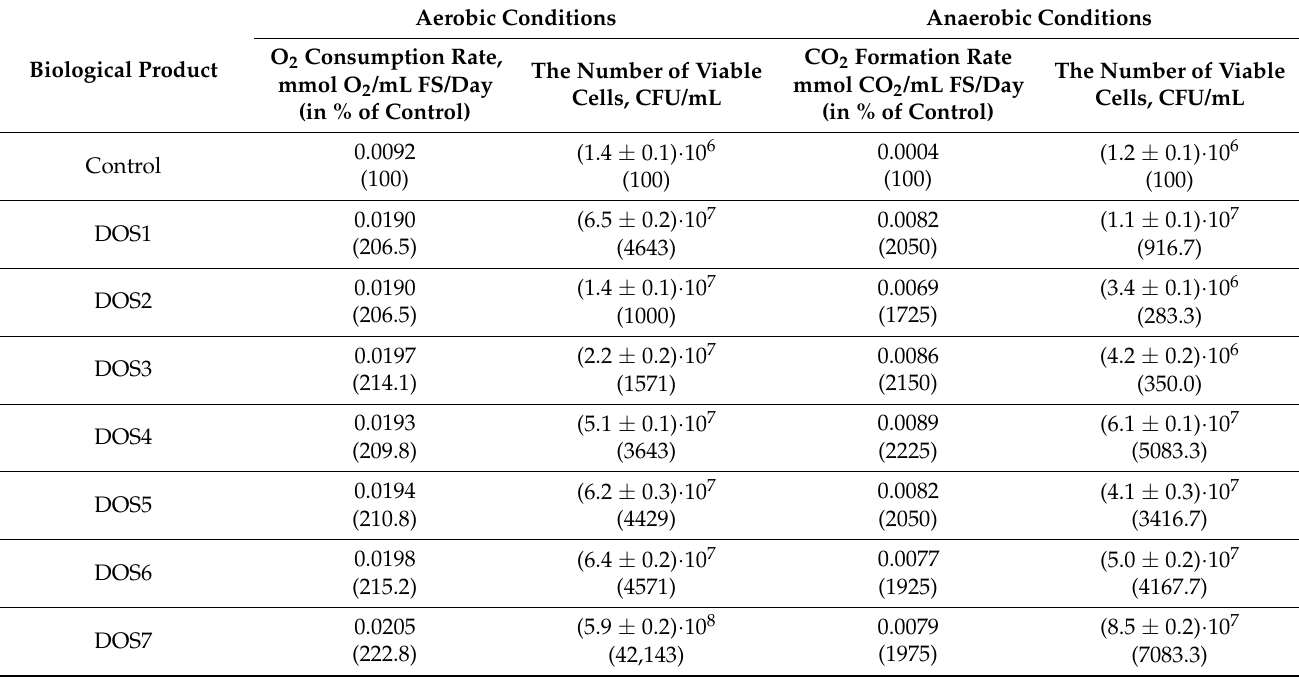
Table 5. Biotechnological indicators of FS biodegradation processes under aerobic and anaerobic